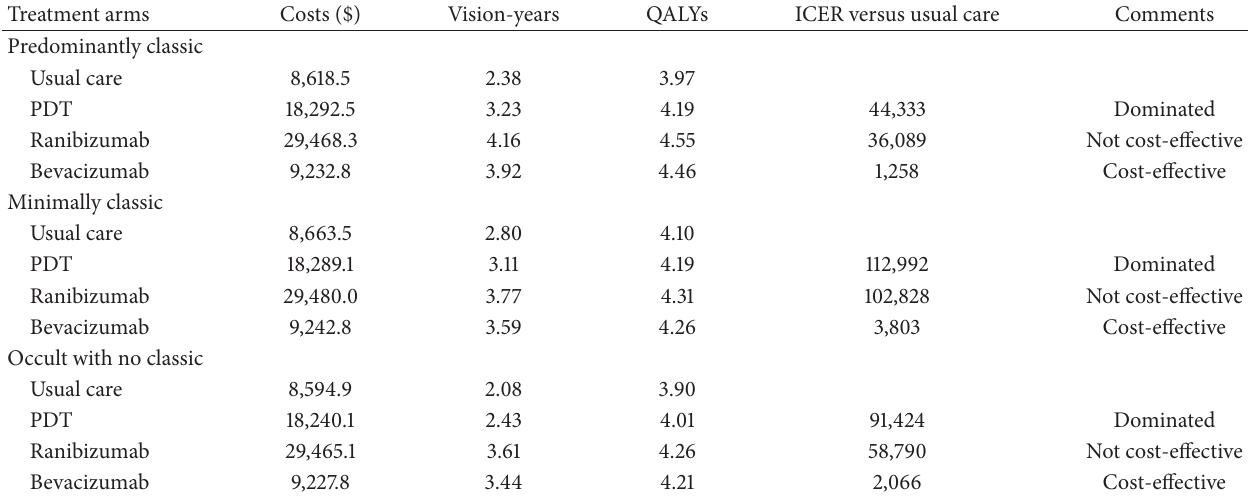
Table 4: Lifetime results for the reference